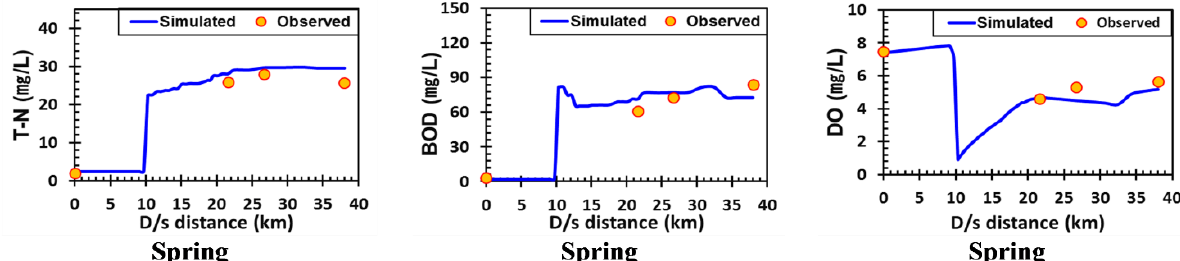
Figure 4. Calibration of water qualities in the Yamuna Waterway for the spring season.